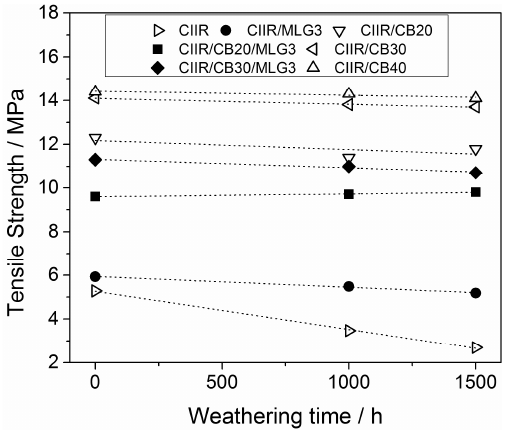
Figure 13. Tensile strength of CIIR and its composites as a function of the weathering/exposure duration time. The lines are visual guides.